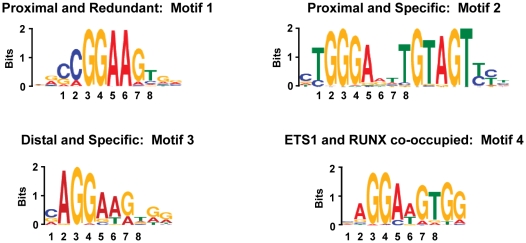
Distinct sequence motifs are over-represented in different subsets of ETS1 bound regions.The indicated subsets of ETS1 bound regions were rank ordered by log transformed binomial P value and the top 250 regions were searched for over-represented sequences by MEME [24]. The most over-represented position weight matrix for each subset is represented (E-values: Motif 1, 9.9×10−281; Motif 2, 2.8×10−287; Motif 3, 8.8×10−105; Motif 4, 1.8×10−142). The height of each nucleotide indicates conservation at that position. Eight nucleotide positions in ETS binding sites are numbered for reference. ETS bound regions were classified either proximal (center of region within 500 bp of a TSS) or distal (center of region greater than 500 bp from a TSS). ETS1 bound regions were classified as redundant if they overlapped with a GABPA bound region and specific if they did not. ETS1 bound regions were classified as RUNX co-occupied if they overlapped with a RUNX bound region.